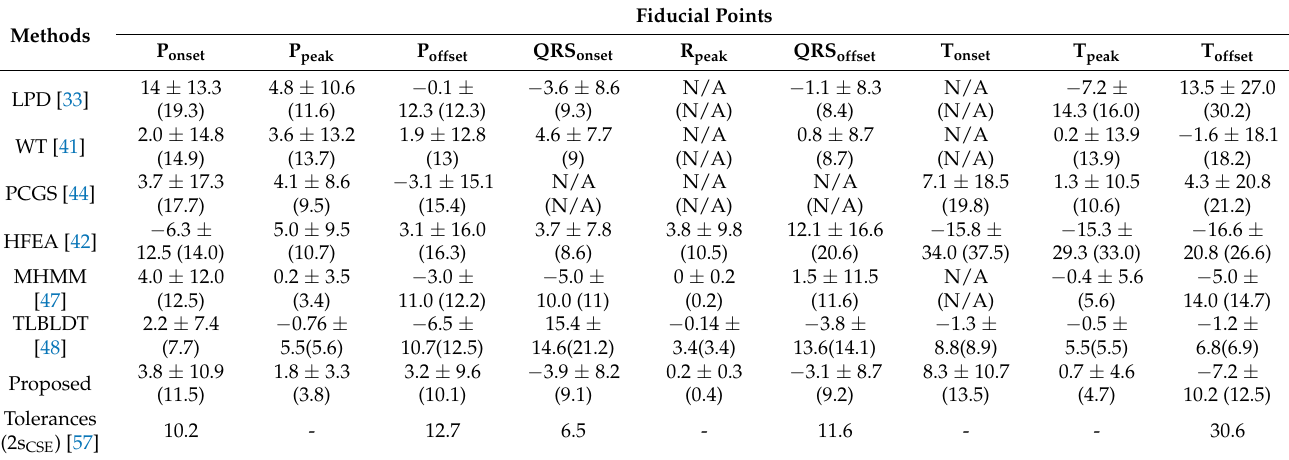
Table 5. Performance comparison of PQRST complex detection from QT-DB (N/A: Not applicable). Methods